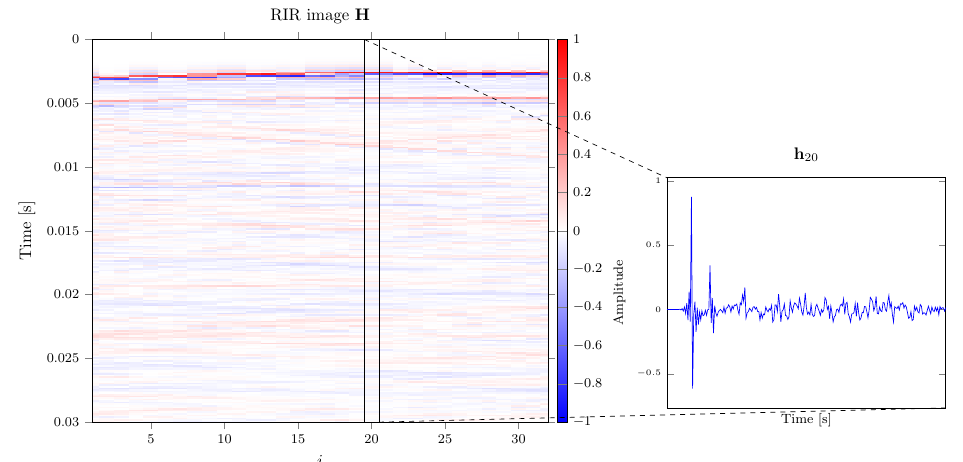
Figure 1. Example of a RIR image. The RIRs of the microphones are arranged along the columns of H